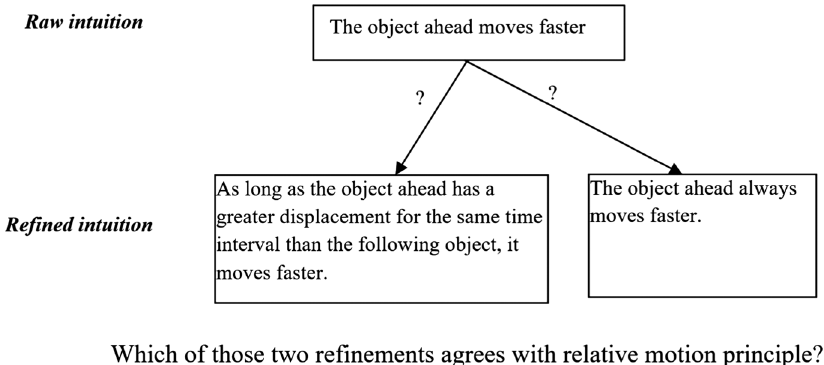
FIG. 2. The refinement diagram for “ the object ahead moves faster ” intuitive